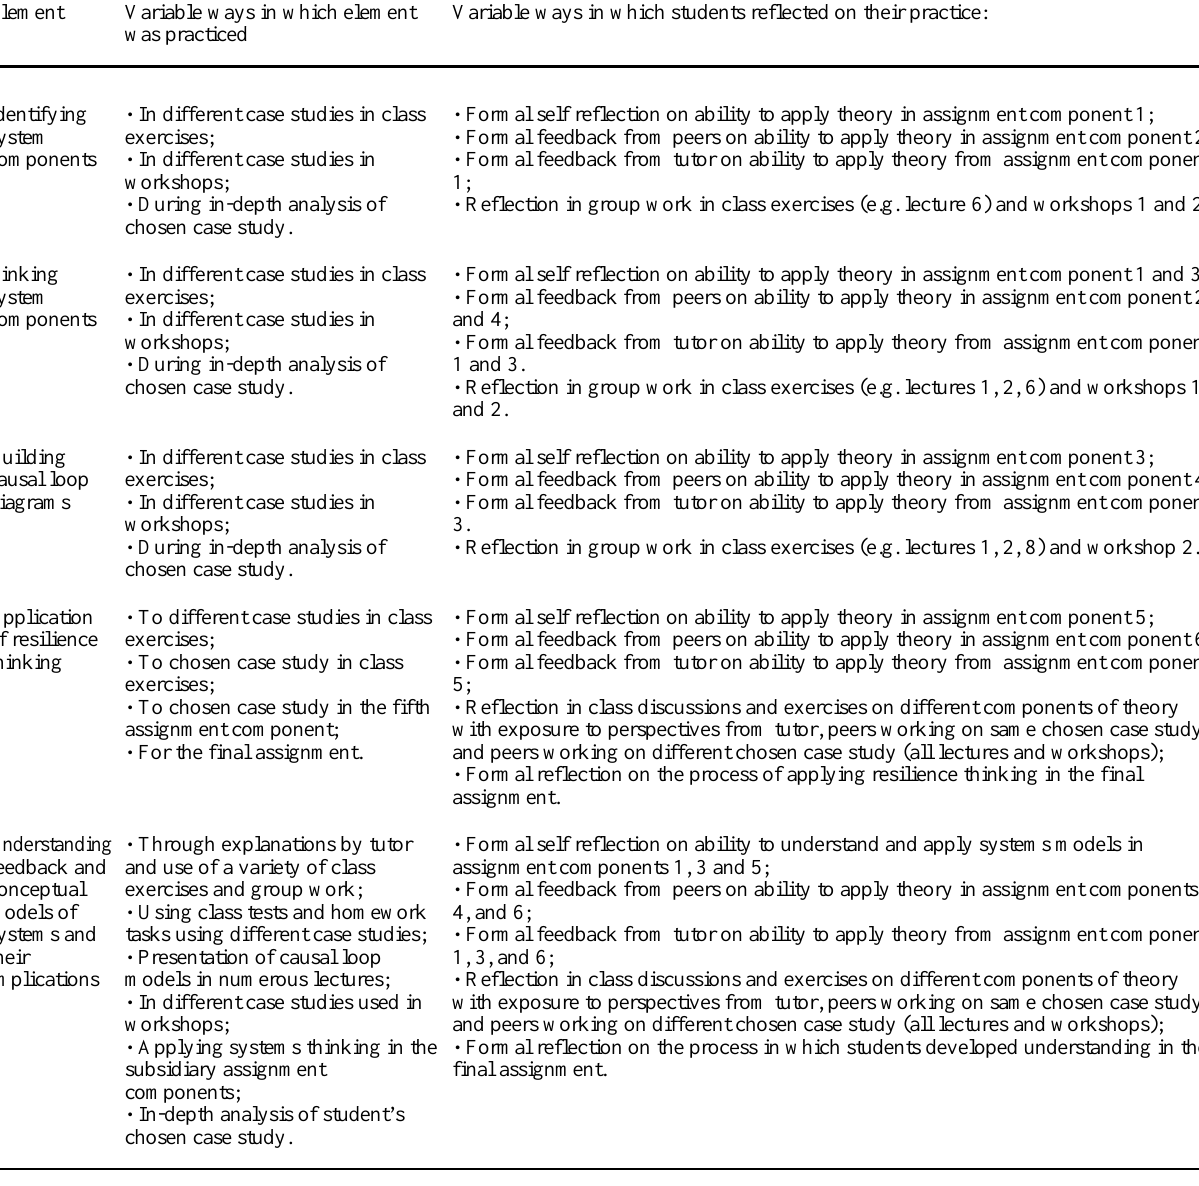
Element Variable ways in which element Variable ways in which students reflected on their was practiced